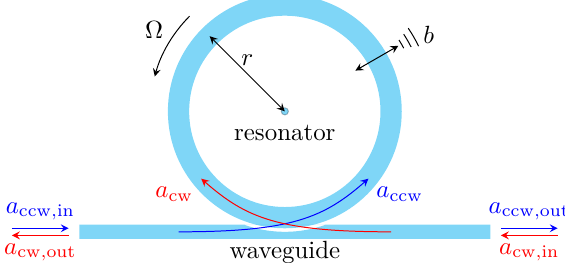
Figure 1. (Color online) Schematic illustration of a spinning optomechanical resonator coupled with a waveguide, where the mechanical mode b is parametrically coupled to two optical cavity modes, i.e., clockwise-propagating mode a cw and counterclockwise-propagating mode a ccw